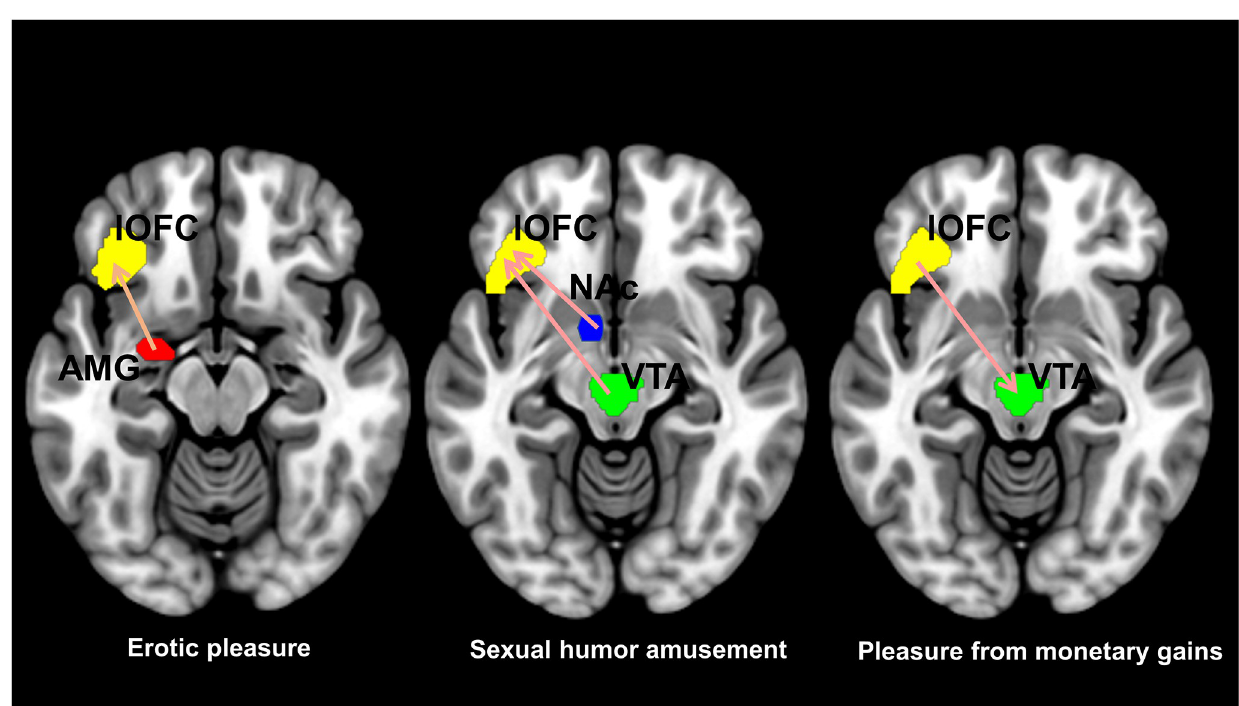
Fig 3. Effective connectivity in processing the consumption of sexual rewards and non-sexual (monetary) rewards with hedonic ratings as covariates during the outcome phase in the lateral orbitofrontal cortex (lOFC). (Left) During the processing of erotic pleasure, there were modulatory changes in amygdala to lOFC (amygdala ! lOFC) effectivity connectivity. (Middle) Sexual humor appreciation was associated with stronger modulatory changes in VTA to lOFC (VTA ! lOFC) and NAc to lOFC (NAc ! lOFC) effectivity connectivity. (Right) Experiencing pleasure from monetary gains was associated with stronger modulatory changes in lOFC to VTA (lOFC ! VTA) effectivity